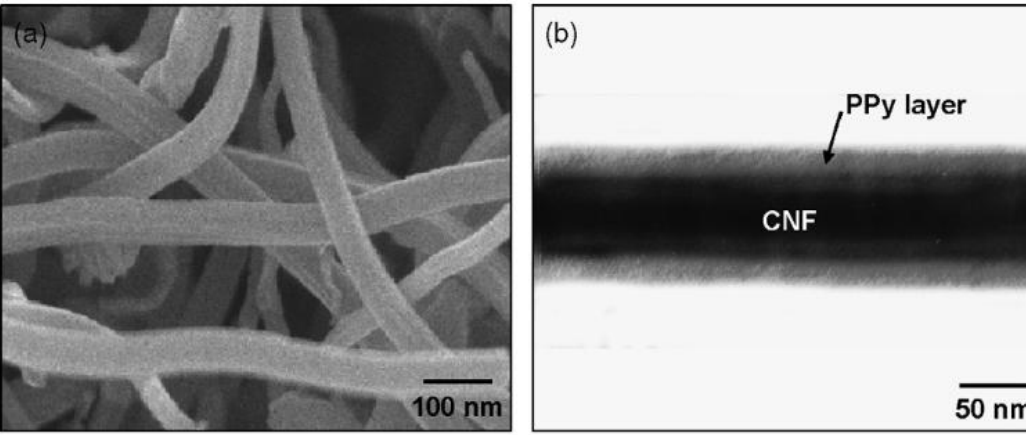
Figure 11. SEM and TEM images of the PPy-coated CNF as a toxic gas sensor